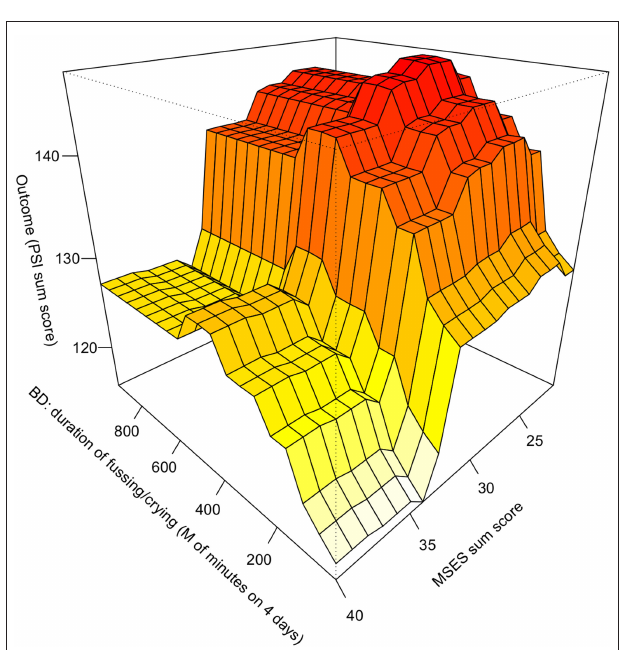
FIGURE 3 | Marginal effect of MSES sum score together with the duration of fussing/crying (BD) on predicted PSI value. BD, 96-hour behaviour diary; MSES, Maternal Self-Efficacy Scale; PSI, Parenting Stress